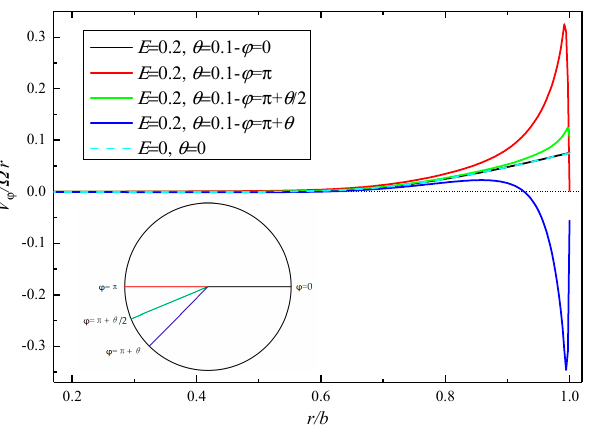
Figure 3. The β in different circumferential positions when the Re ϕ = 5.12 × 10 5 at z / s = 0.5.